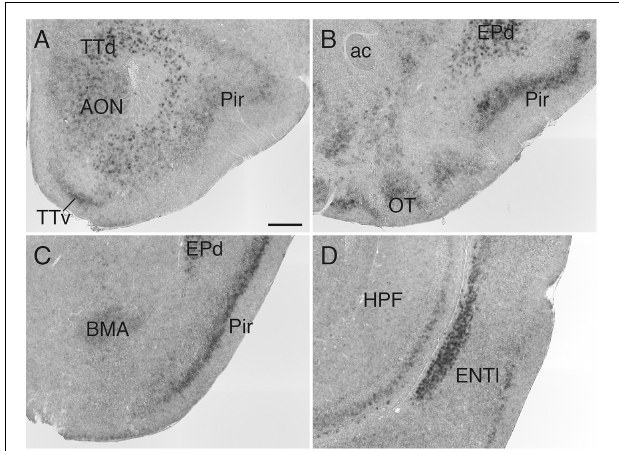
FIGURE 1 | Sulf1 mRNA expression in the olfactory cortex. (A–D) Sulf1 was expressed in the anterior olfactory nucleus (AON), tenia tecta (TTd, TTv), olfactory tubercle (OT), piriform cortex (Pir), dorsal endopiriform nucleus (EPd), and lateral entorhinal cortex (ENTl). ac, anterior commissure; BMA, basomedial amygdalar nucleus; HPF, hippocampal formation. The scale bar indicates 250 µ m. Approximate AP levels from the bregma (in mm) are 2.5 (A) , 1.0 (B) , –1.5 (C) , and − 3.0 (D) .